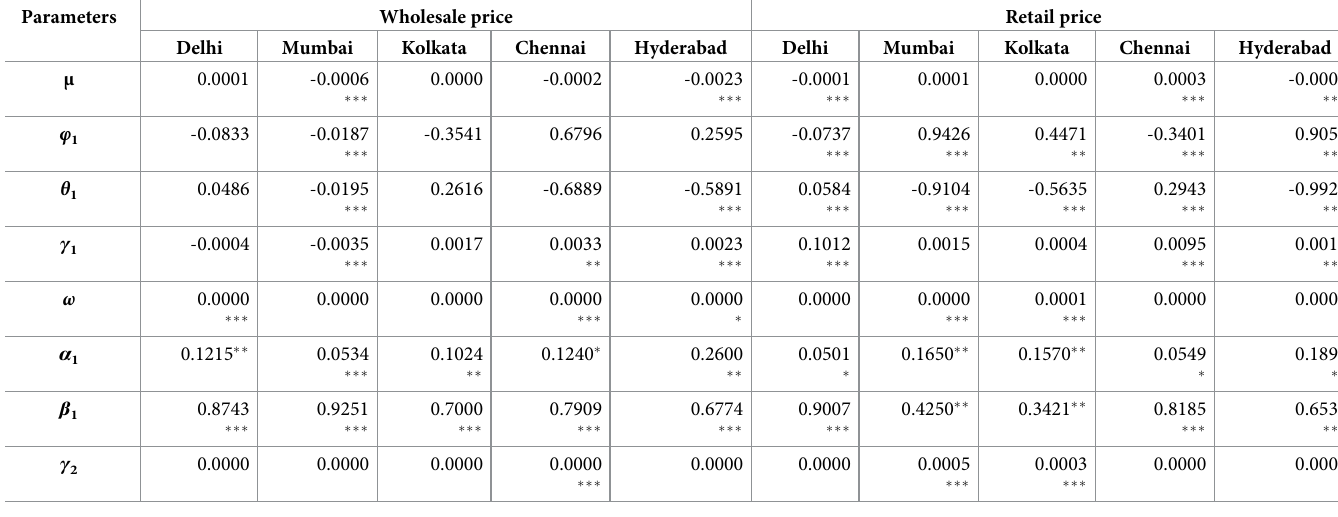
Table 1. Parameters estimate of GARCH-X model for gram.